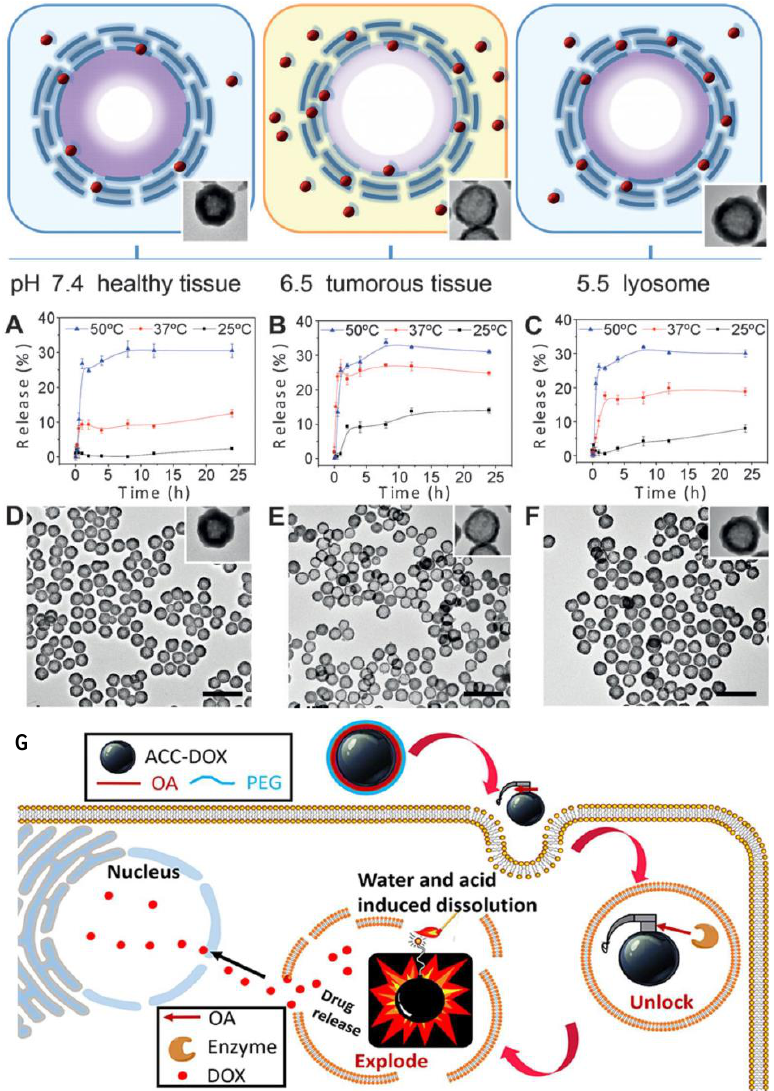
Figure 6. Schematic description of the pH-responsive drug release of ACC-DOX@silica nanoparticles. Reproduced with permission from [145]. Wiley Publishing Groups, 2012. Cumulative releases of doxorubicin (DOX) from ACC-DOX@silica suspensions in various aqueous buffers at ( A ) pH 7.4; ( B ) pH 6.5 and ( C ) pH 5.5 with different temperatures of 25, 37 and 50 ◦ C. Representative TEM images of the suspensions under 37 ◦ C at ( D ) pH 7.4; ( E ) pH 6.5 and ( F ) pH 5.5. Reproduced with permission from [145]. Wiley Publishing Groups, 2012. The scale bars are 500 nm. ( G ) Schematic illustration of assembly process and disassemble mechanism of PEG/OA-ACC-DOX within cancer cells. Reproduced with permission from [136]. Royal Society of Chemistry,